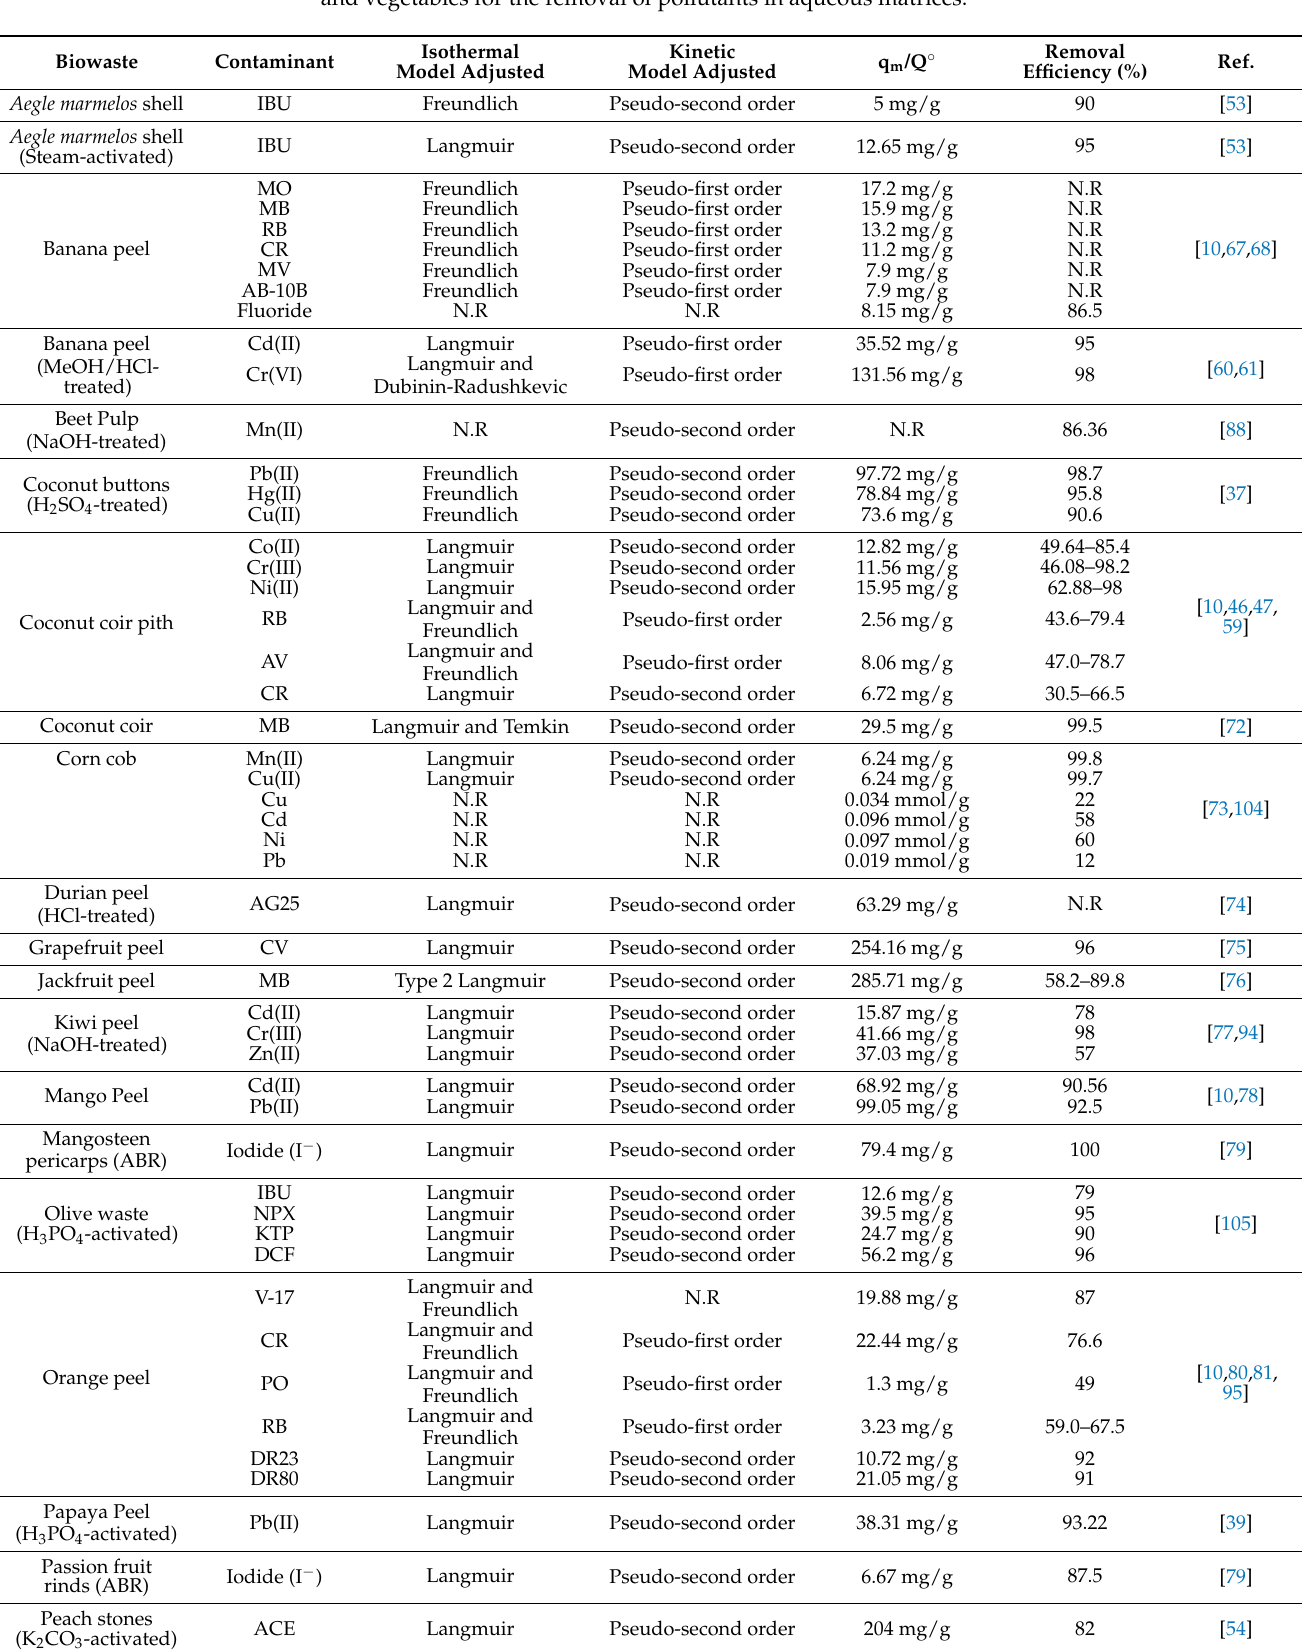
Table 4. Adsorption parameters and removal efficiencies of different biosorbents derived from fruit and vegetables for the removal of pollutants in aqueous